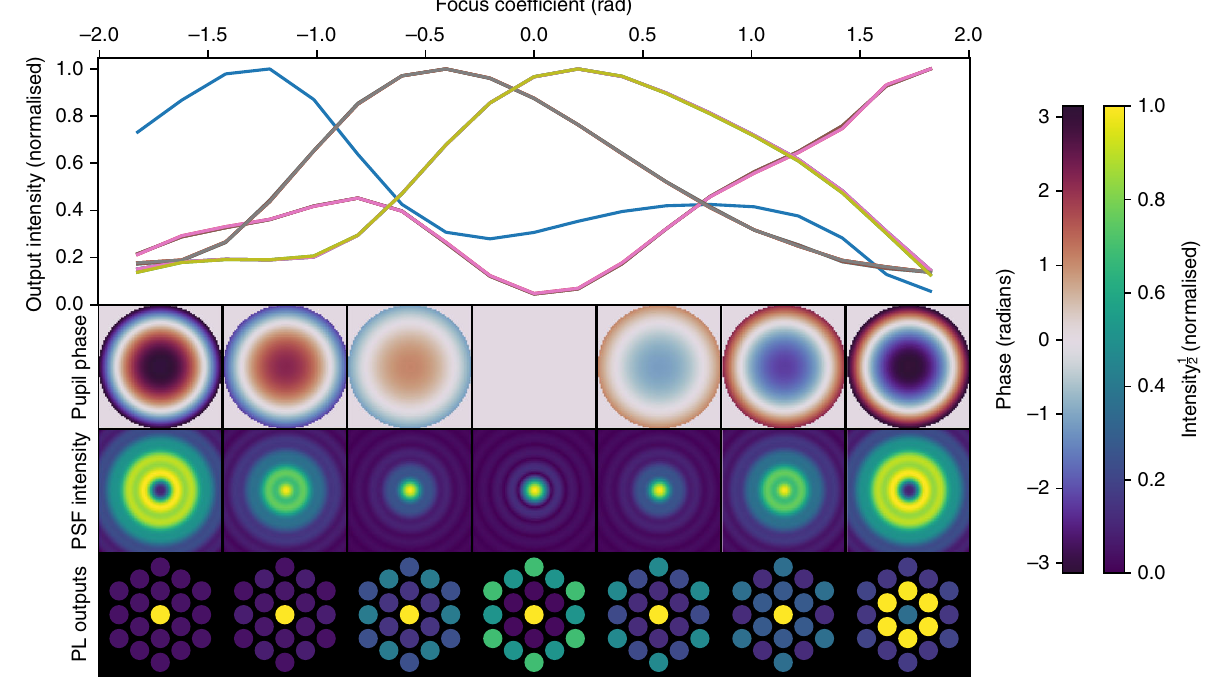
Fig. 2 Photonic lantern wavefront sensor ’ s non-degenerate response to a varying degree of defocus. Results of simulations where a defocus term is applied and its amplitude scanned from − 2 to + 2 radians. In the top panel, the normalised output intensities of the the 19 single-mode outputs are plotted as a function of defocus amplitude (although only four separate trends are seen due to the symmetry of this aberration). In the lower three rows the pupil phase, PSF intensity and PL outputs are shown as per Fig. 1. It is seen that although positive and negative defocus terms of the same amplitude give identical PSFs, it is unambiguous in the measurements from the PL. However, it is also seen that there is not a simple linear relationship between the amplitude of the phase error and the intensity of the lantern outputs. Simulations are performed at a wavelength of 1550 nm. Intensities are plotted with a square-root stretch to better show faint